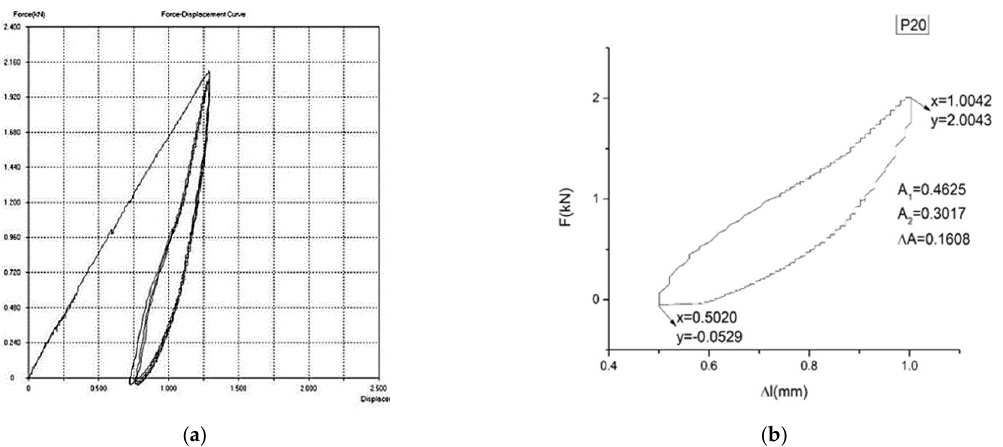
Figure 7. Force–displacement diagram for sample P20: ( a ) F = f( Δ l) for 5 cycles of loading–unloading. ( b ) F = f( Δ l) for the last cycle of loading–unloading. The yield of sample P20 is η = 34.76%.